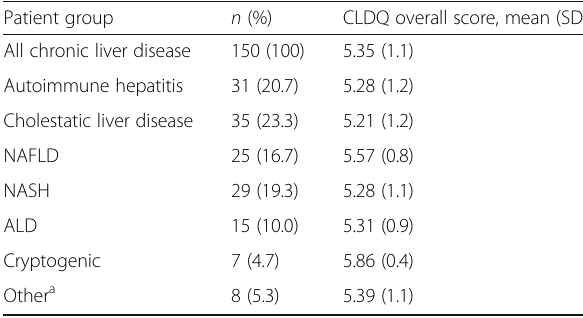
Table 4 CLDQ overall score (Alt et al., 2016) [11] Patient